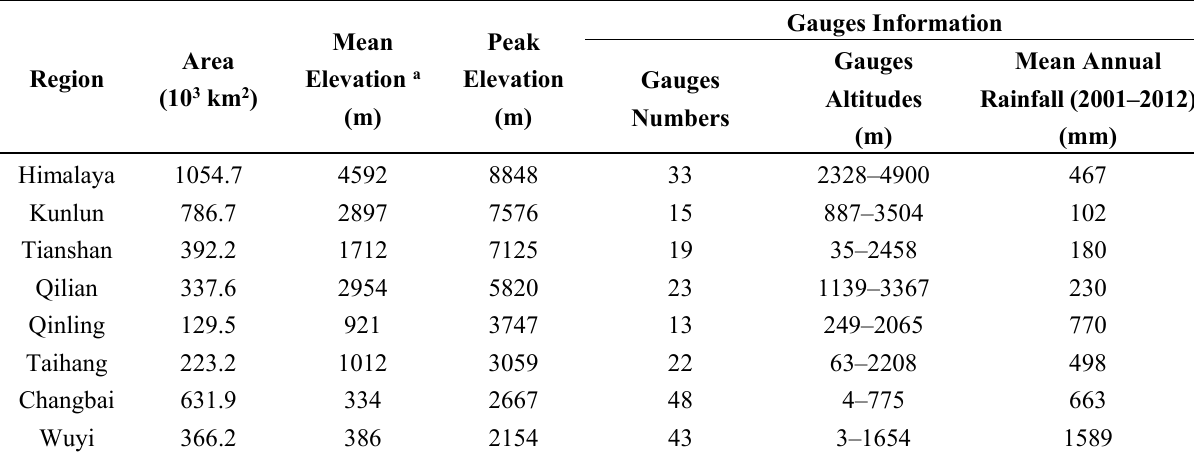
Figure 2. The location of the studied mountainous areas of China. The red lines are the boundaries of the mountainous areas, and the blue dots are the gauge stations. Table 1. Basic information for the studied mountainous